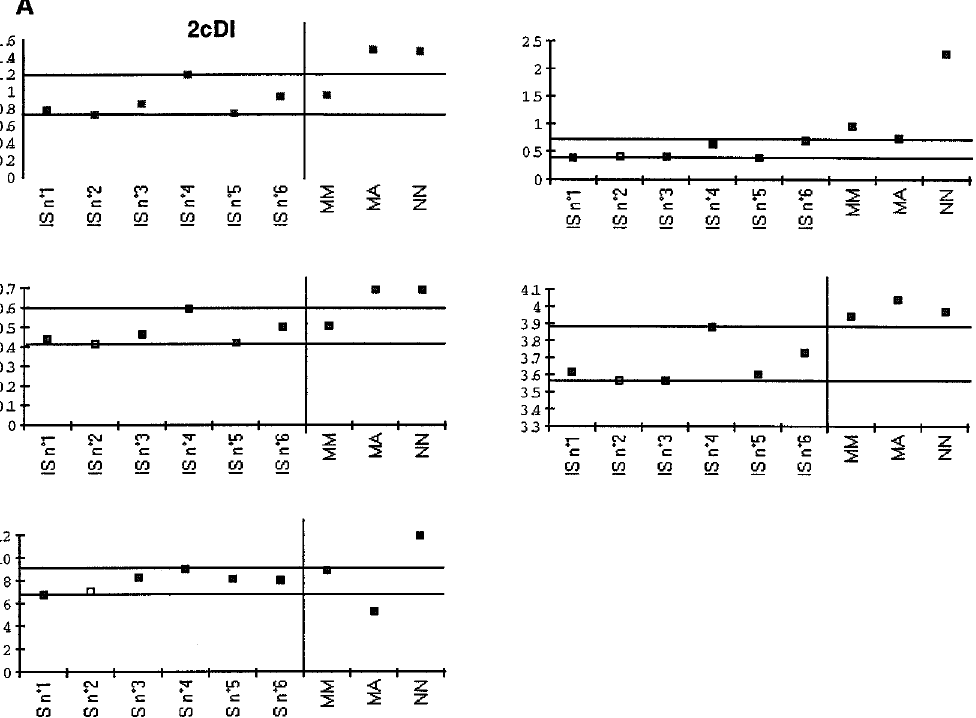
Fig. 4. DNA indices values (A: 2cDI, B: 5cER, C: MG, D: DE, E: SPF) obtained after the elimination of debris and aggregates by the six interactive sortings (on the left) and by the 3 automatic methods (on the right) for astrocytoma grade 2. Horizontal lines delimit lowest and highest values for each DNA indice obtained after the interactive elimination of debris and and aggregates. Vertical lines separate interactive sortings from automatic